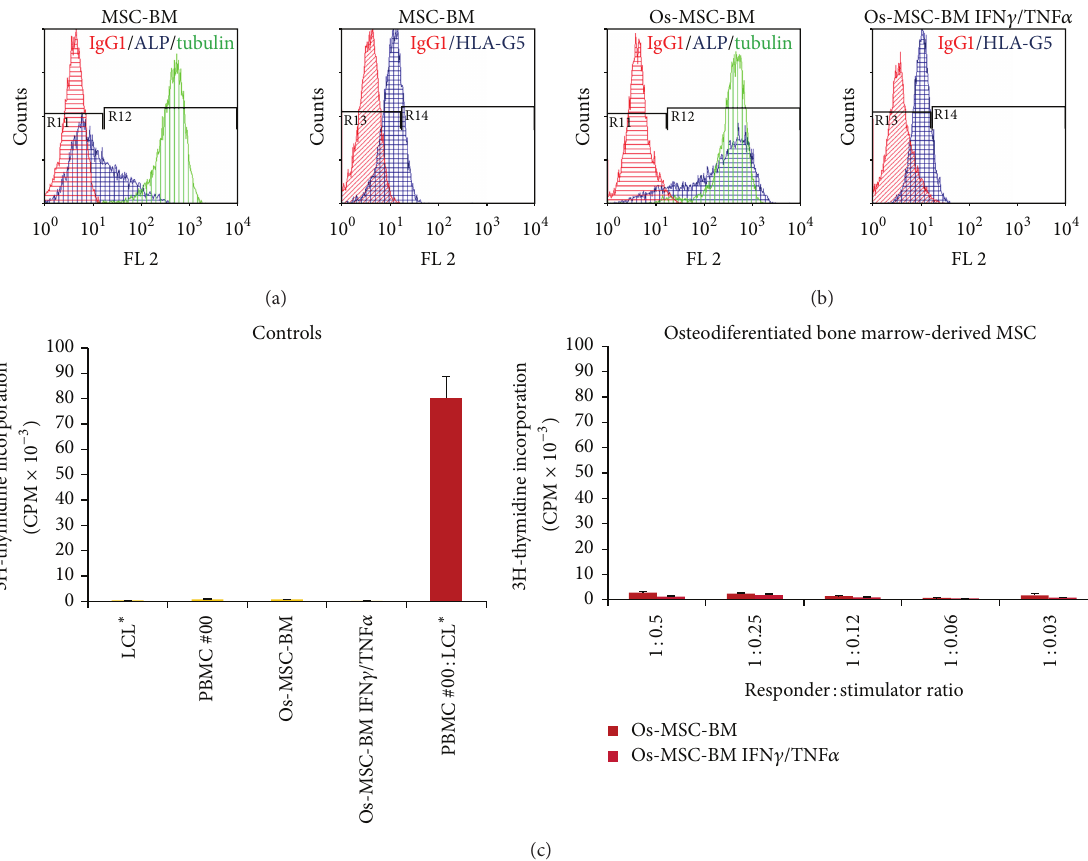
Figure 3: BM-derived MSCs committed to osteodifferentiation process express HLA-G and are hypoimmunogenic. (a and b) Expression of ALP and HLA-G5 was evaluated by intracellular flow cytometry analysis on BM-derived MSCs committed to 14-day osteodifferentiation process and pretreated with IFN 𝛾 and TNF 𝛼 (Os-MSC-BM IFN 𝛾 /TNF 𝛼 ) or not (Os-MSC-BM). IgG1 was used as isotype control Ab. Tubulin was used as positive control of cell permeabilization. (c) PBMC from healthy individual (#00) were used as responder cells towards BM- derived MSCs committed to osteodifferentiation process and pretreated with IFN 𝛾 and TNF 𝛼 (Os-MSC-BM IFN 𝛾 /TNF 𝛼 ) or not (Os-MSC- BM) as stimulating cells at various responder: stimulator ratios. Irradiated LCL ∗ were used as positive control of T cell alloproliferation. Results are given as mean cpm ± s.e.m.; one representative experiment is